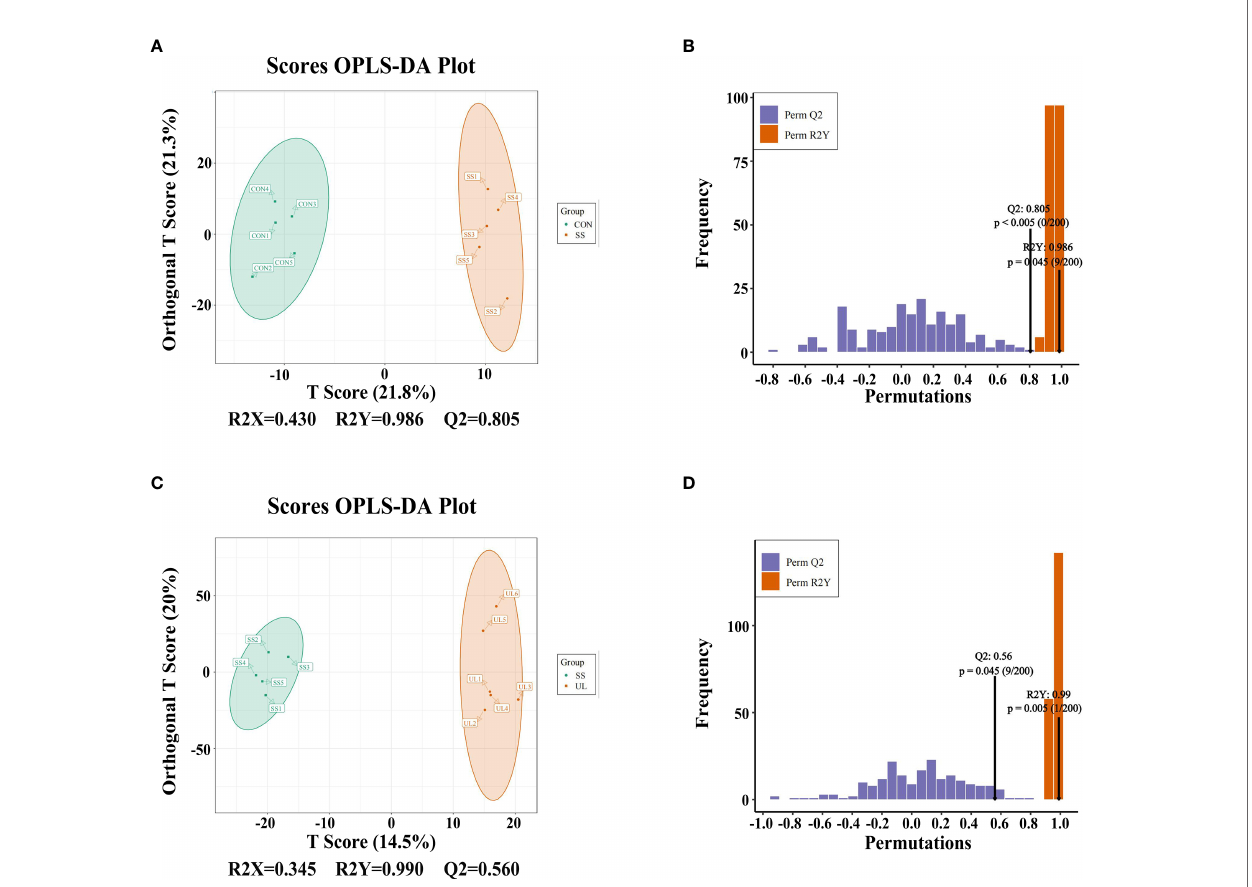
FIGURE 4 | OPLS-DA analysis was performed to show the metabolite pro fi le (UL: n = 6, CON: n = 5, SS: n = 5). OPLS-DA score plot and OPLS-DA model test chart showed good discrimination between CON and SS groups with R 2 X = 0.430, R 2 Y = 0.986, Q 2 = 0.805, p-value < 0.05 (A, B) . OPLS-DA score plot and OPLS-DA model test chart showed good discrimination between UL and SS groups with R 2 X = 0.345, R 2 Y = 0.990,Q 2 = 0.560, p-value < 0.05 (C, D) . CON, control group; UL, unilateral labyrinthectomy group; SS, sham surgery